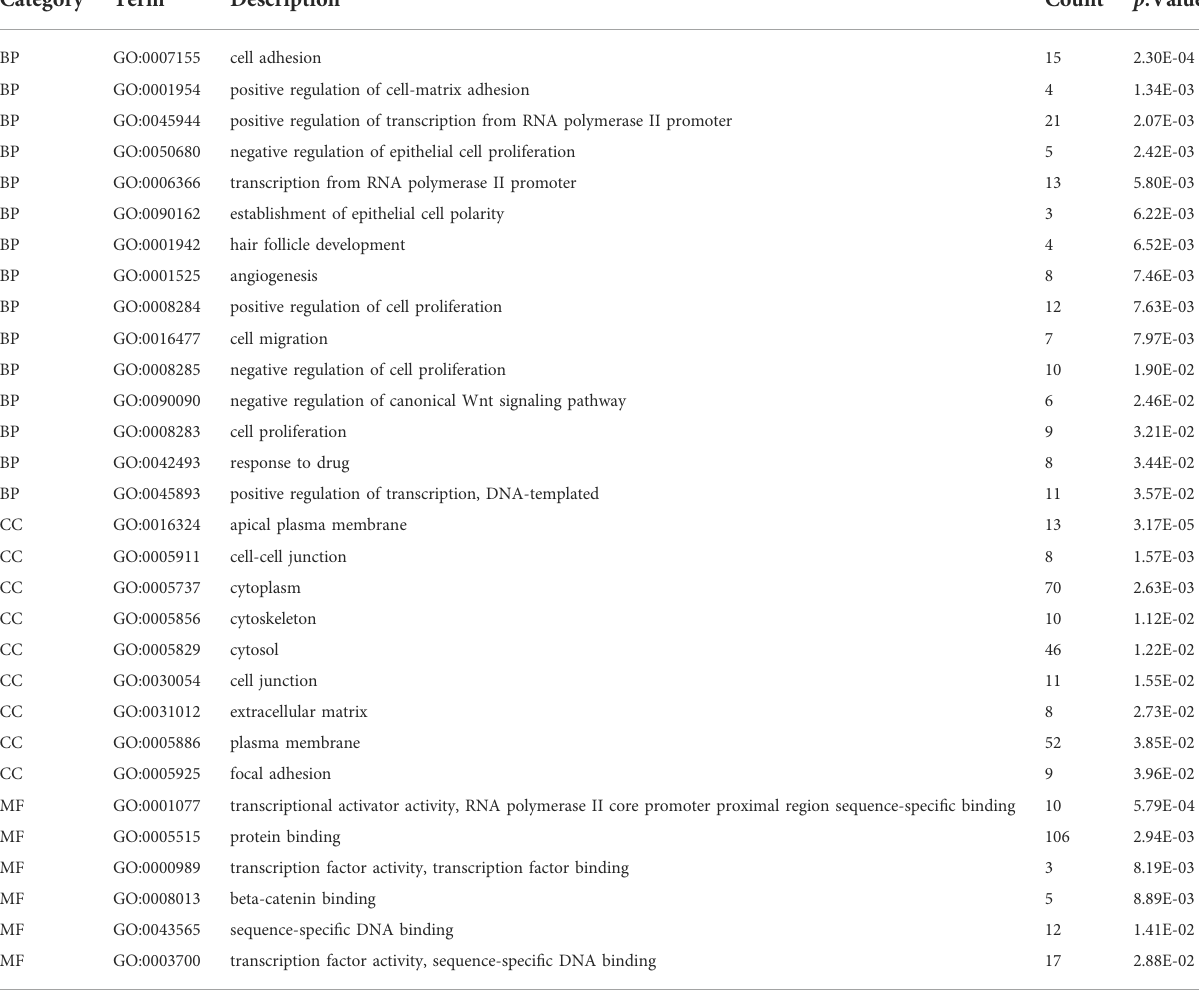
TABLE 2 Gene ontology enrichment analysis of hypermethylated downregulated genes.